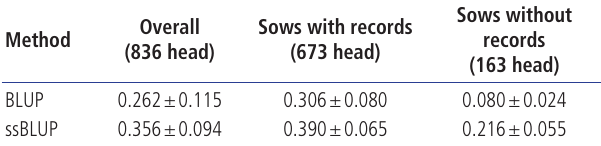
Table 4. Means and standard deviations of estimated breeding value (EBV) and genomic estimated breeding value (GEBV) accuracies in animals with or without records for the total number of piglets born (TNB) by the estimation methods